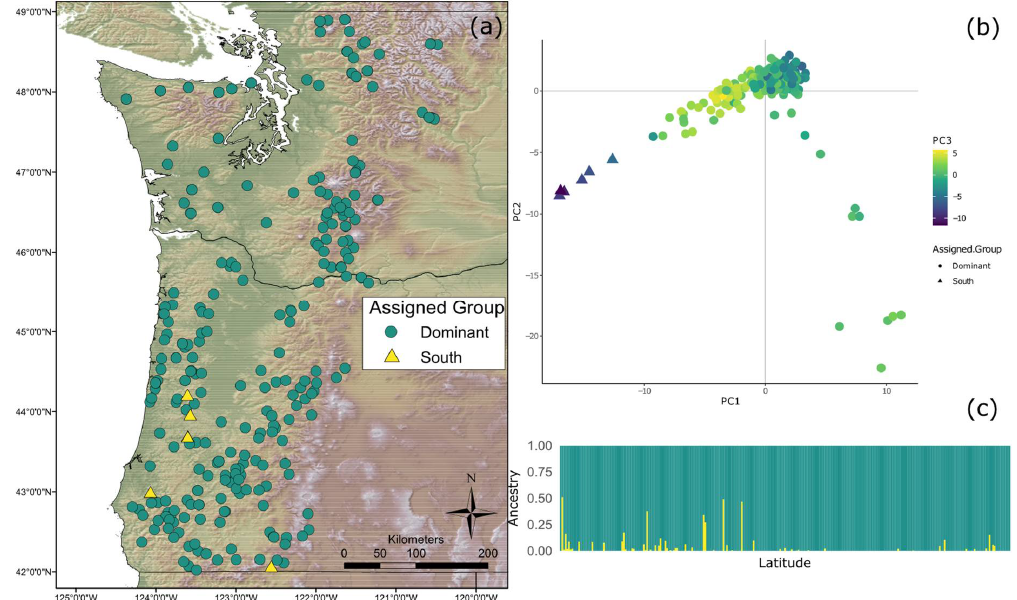
Figure 1. ( a ) Map of sample locations by population structure. Green circles represent Coastal Dominant (CD) individuals while yellow triangles represent individuals with significant Coastal South (CS) ancestry; ( b ) Population structure based on principal component analysis (PCA) results. PCA was carried out in Adegenet and only accounts for genotype. The first three principal components are represented by the x -axis, y -axis, and the color, respectively; ( c ) Structure plot of sampled individuals as determined by fastSTRUCTURE. Each bar along the x -axis represents an individual and the individuals are ordered by latitude (increasing left to right). Green represents ancestry from the CD genetic group, while yellow represents the level of ancestry from the CS genetic group.